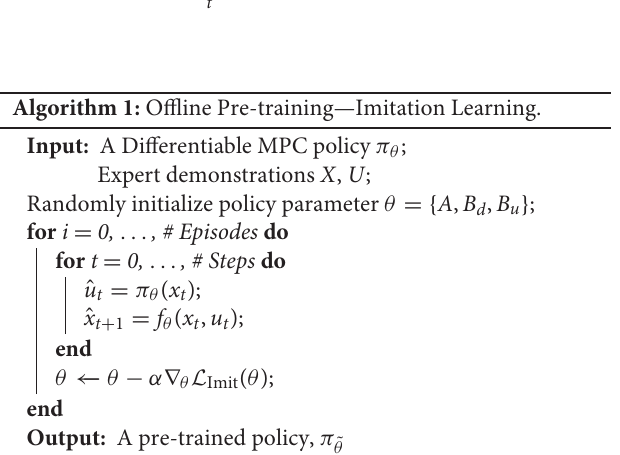
Algorithm 2: Online Learning—PPO (Modified from Schulman et al.,